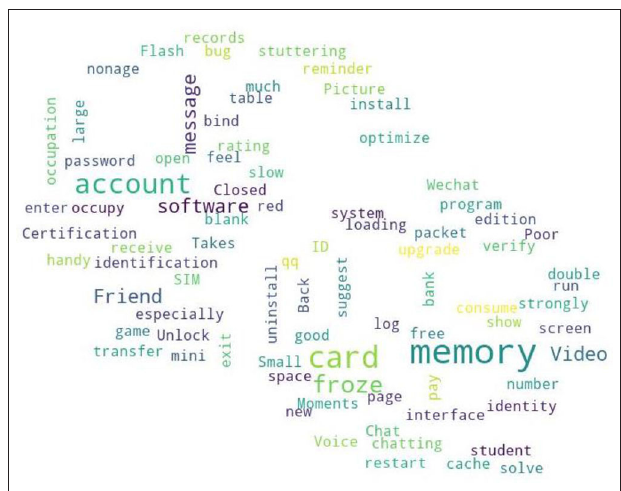
FIGURE 4 | Function needs of